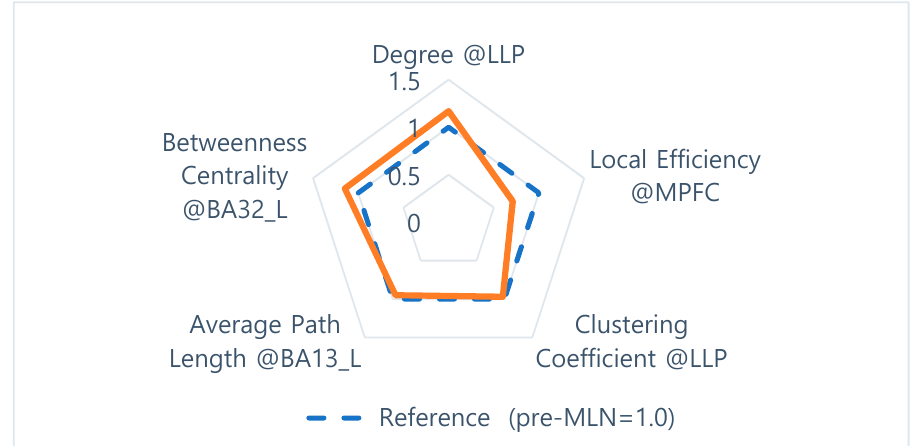
Figure 7. Multivariable comparison of the neural network indexes before and after MLN drug treatment (normalized by the index of pre ‐ medication).